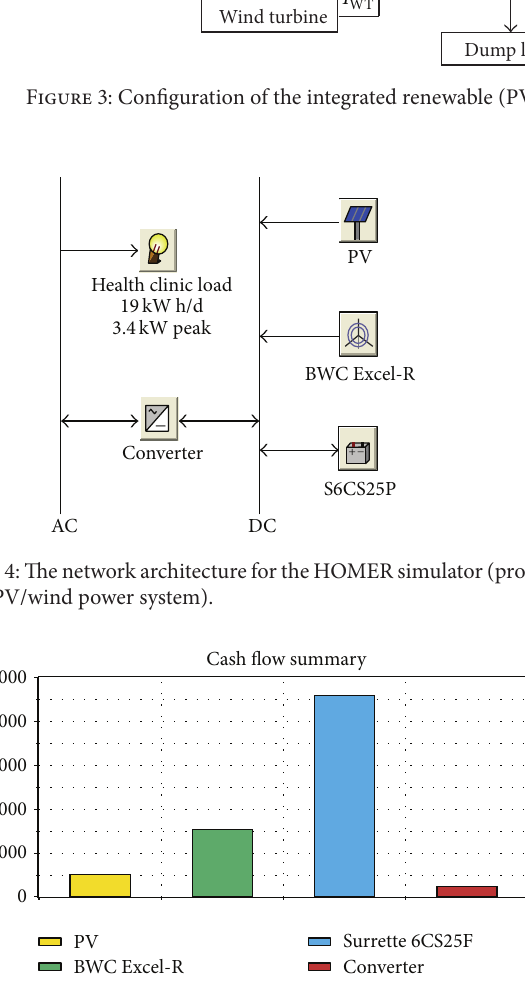
Figure 5: Net present cost of components of the integrated renew- able PV/wind energy system.